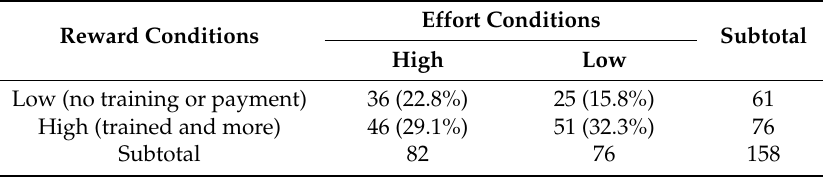
Table 2. Cell sizes in different conditions ( N = 158).